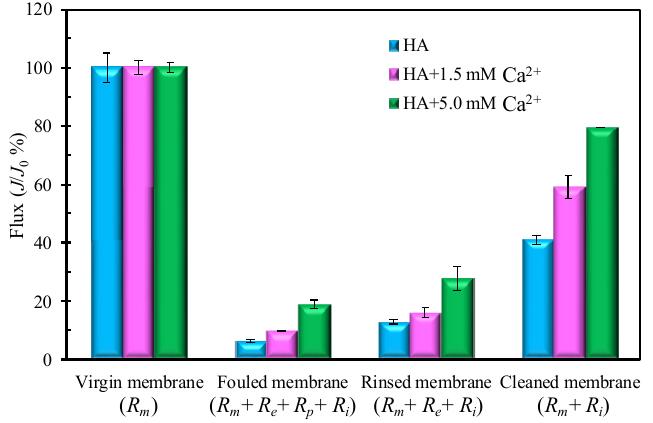
Figure 1. Comparison of membrane filtration flux after different operational steps under different Ca 2+ concentrations ( ∆ P = 2 bar).